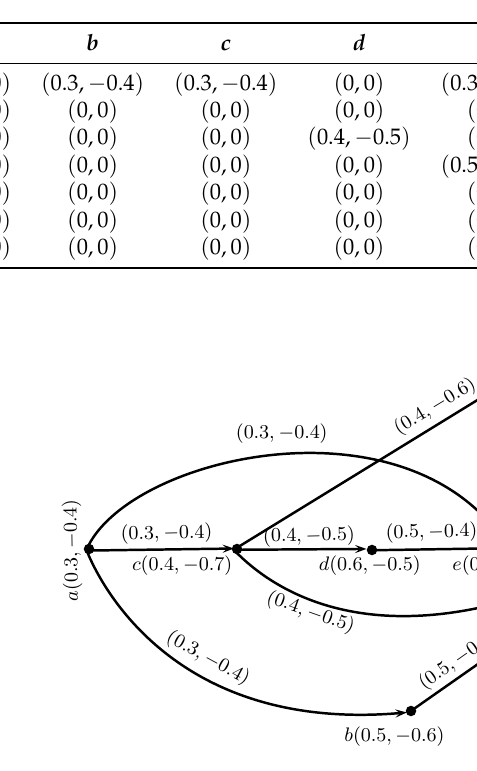
Table 2: Bipolar fuzzy in neighbouhood